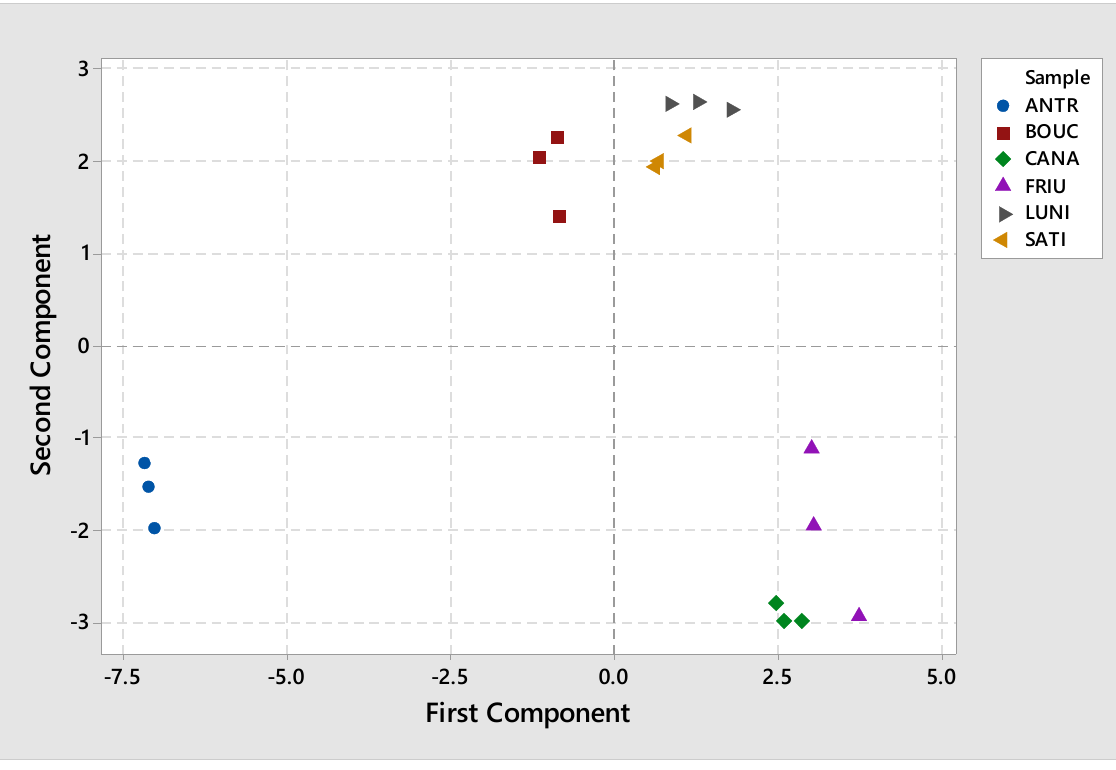
Figure 7. Principal component analysis (PCA_2) score plot of the tested CFs. Mean values ( n = 3) were included for each sample. Flour IDs were reported in Table 1.